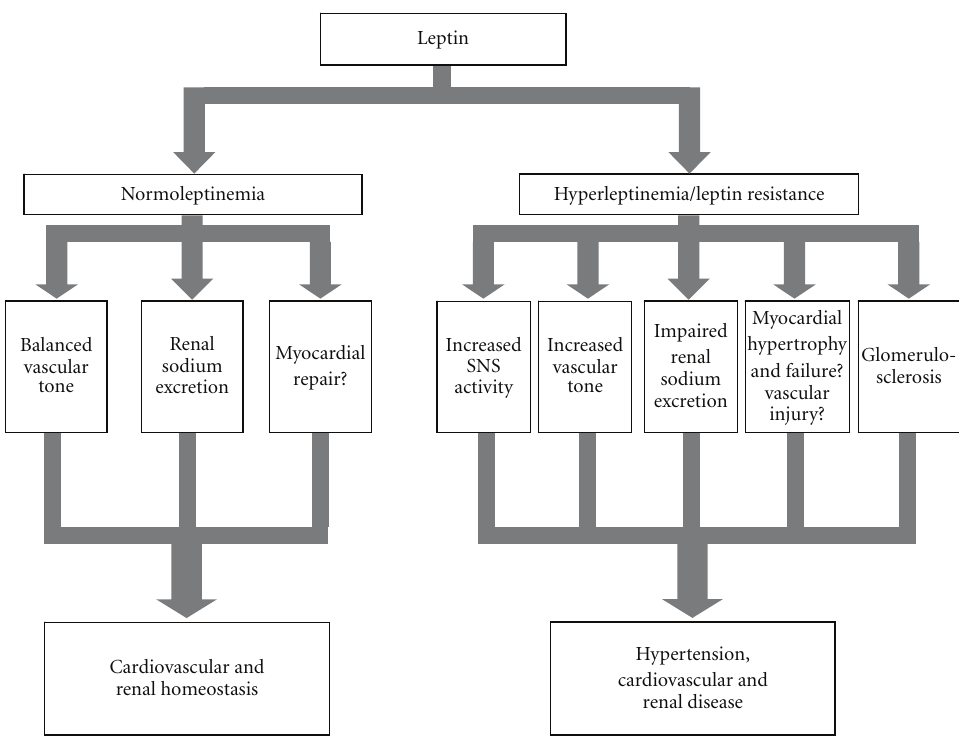
Figure 1: Cardiovascular and Renal Actions of Leptin. SNS: sympathetic nervous system. Adapted from Kshatriya S, Reams GP, Spear RM, Freeman RH, Dietz JR, Villarreal D. Current Opinion in Nephrology and Hypertension, 2010 Jan; 19 (1): 72 − 8. With Permission from Wolters Kluwer/Lippincott, Williams &